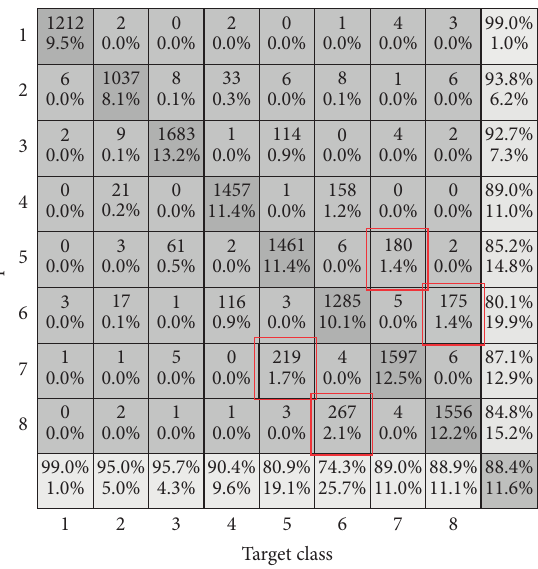
Figure 10: Classification according to the number of